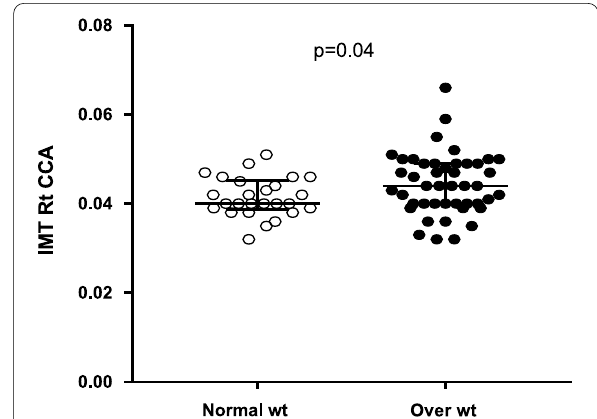
Fig. 1 Student’s T -test comparing the intimal medial thickness in the right common carotid artery with different groups of body mass index, mean value of IMT in normal wt group 0.42 mm, while mean = value of IMT in over wt group 0.45 mm =